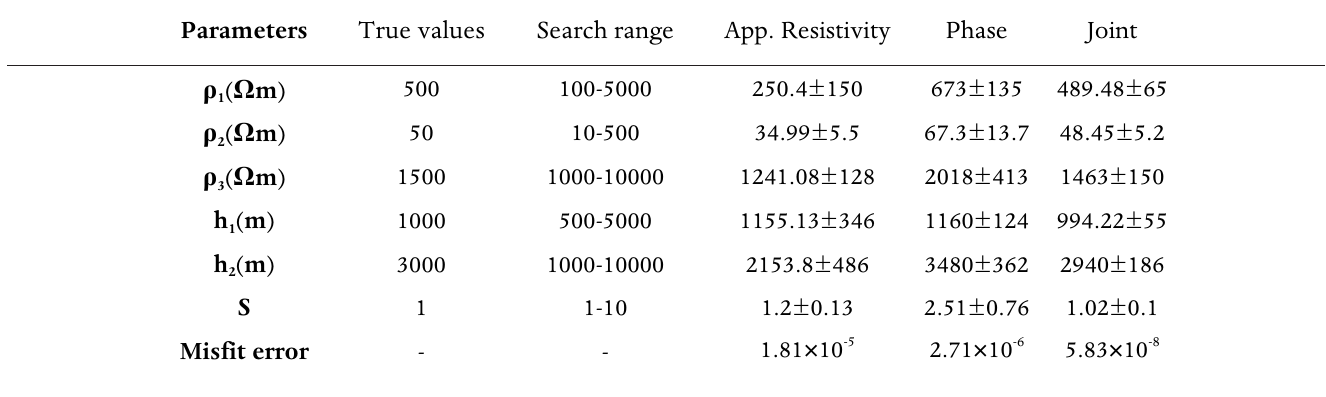
Table 7. Model 4 (zero static shift): inversion results with optimization of static